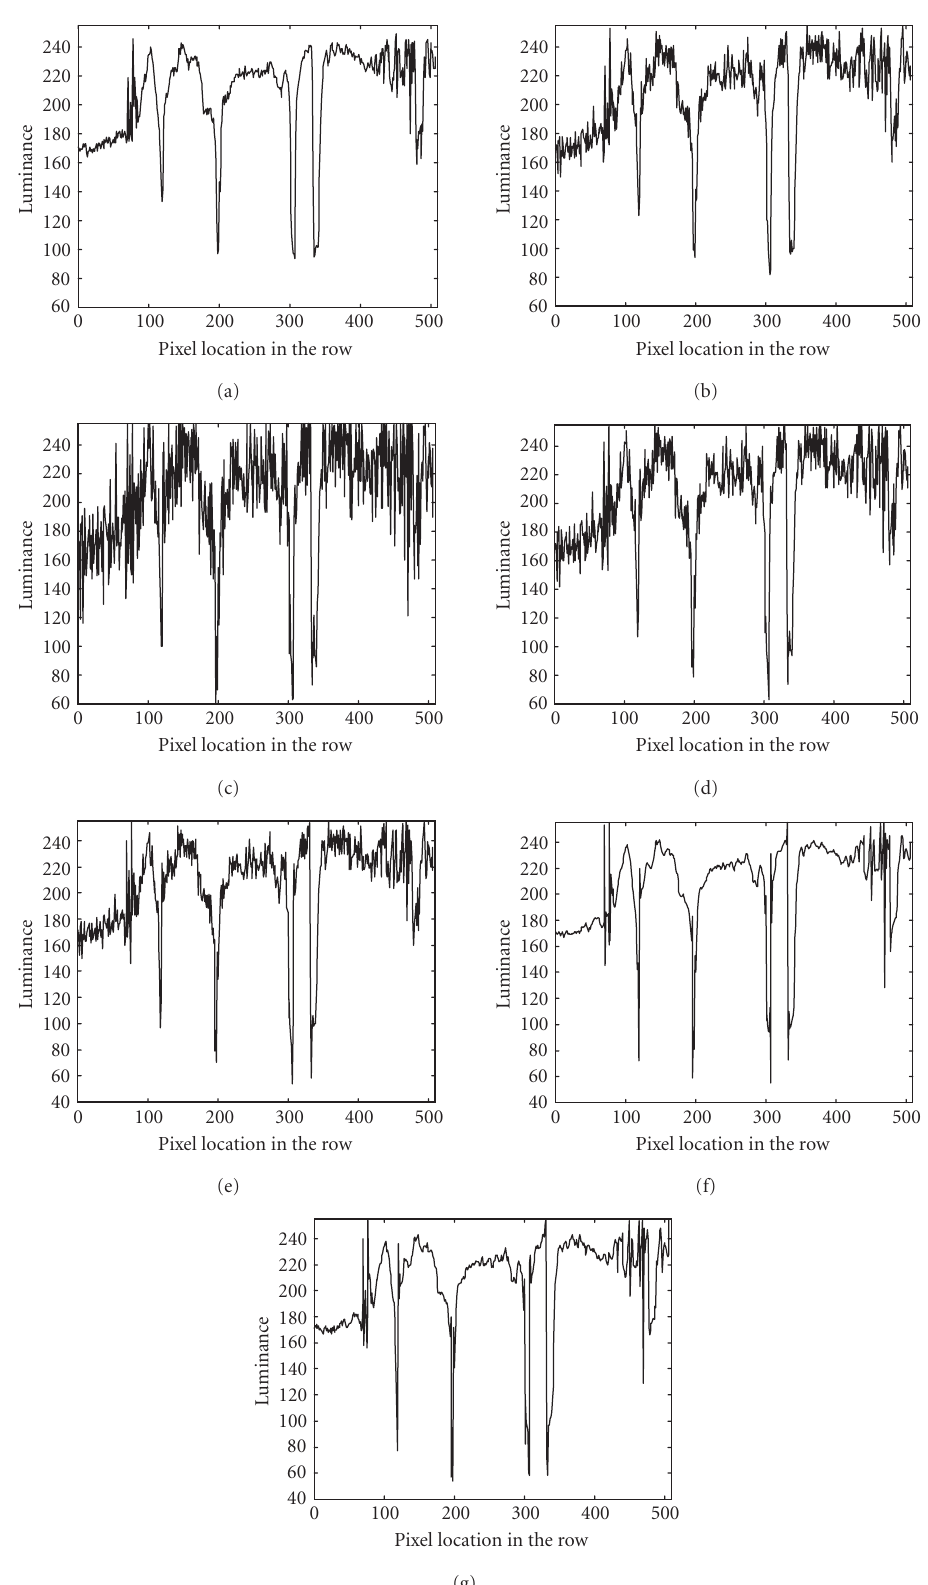
Figure 5: Luminance values of the row 275 (a) in the original image, (b) in the noisy image, and in the results given by (c) linear UM, (d) WM-UM, (e) PWM-UM, (f) FAB anisotropic di ff usion, and (g) proposed